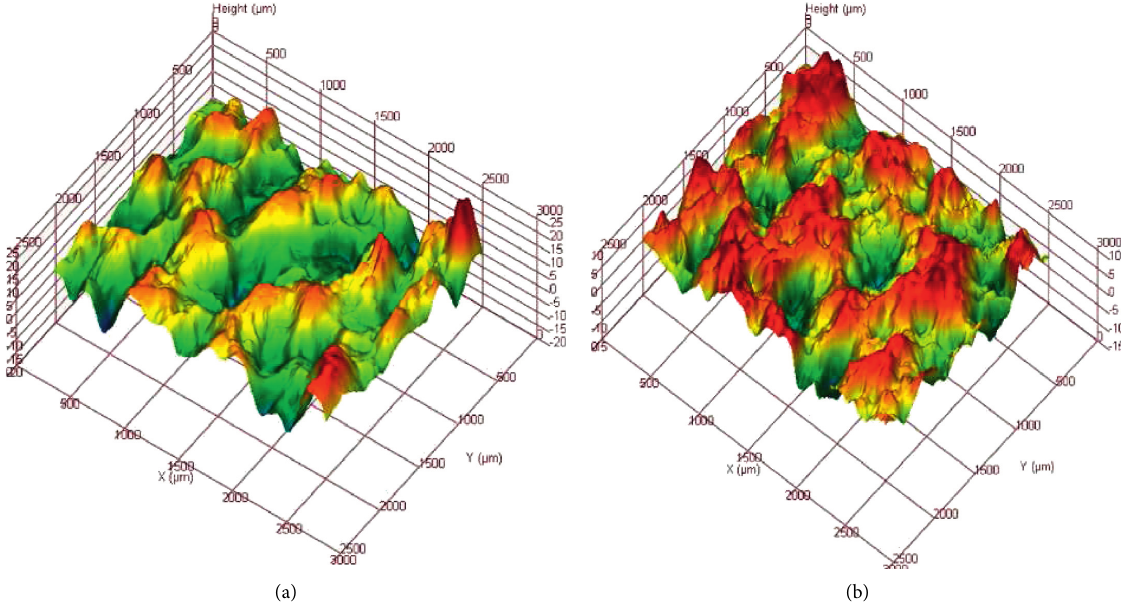
Figure 7: Optical profilometer images of the surfaces with the lowest (a) and highest (b) surface roughness